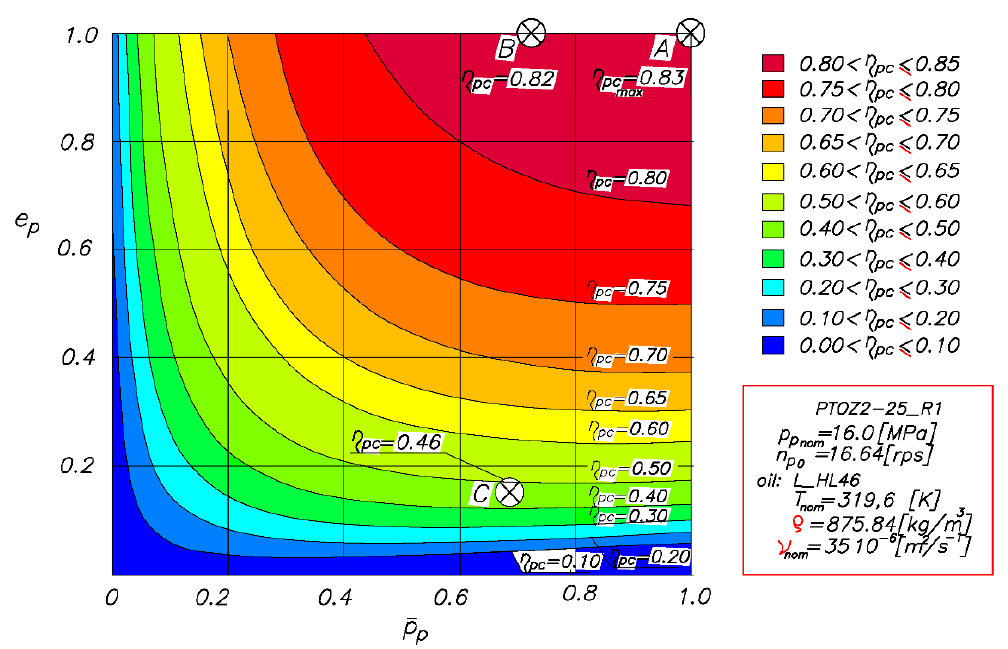
Figure 4. Universal diagram of the dependence of the total efficiency coefficient in the coordinates of the relative load coefficient and the geometric setting of the working volume for the piston-axial pump with a pivoting thrust disc of the PTOZ2-25-R1 type, produced by PZL HYDRAL Wroclaw. Source: own preparation.